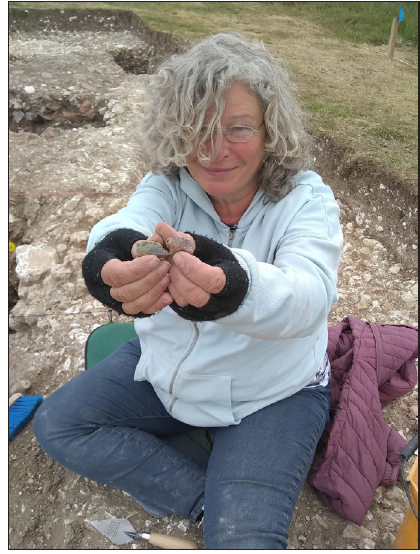
Figure 3: Tanith Furner with finds on exca- vation at Downley, West Sussex, in 2019 (Photo: Wei Ping